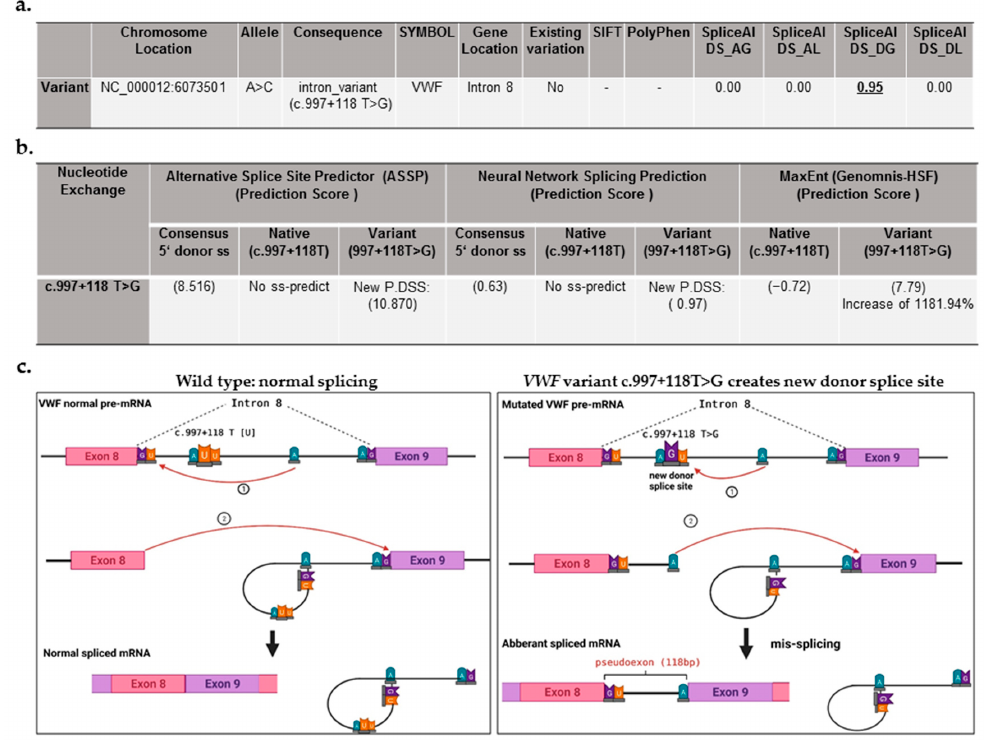
Figure 1. Detection of a deep intronic variant in von Willebrand factor (VWF) gene after executing next-generation sequencing (NGS) and subsequent bioinformatic analysis. ( a ) Data obtained from analysis of variant c.997 + 118 T > G, detected by NGS, using Ensemble Variant Effect Predictor (VEP), including variant annotation, variant location, the existing variant in public variant data- bases, and predicting its pathogenic effect. Genomic location of VWF variant is annotated based on latest assembly (GRCh38/hg38: chr12: 5,948,877–6,124,770). No: not existing in the public variant databases. SpliceAl (Illumina artificial intelligence splicing prediction software) prediction scores include DS_AG (delta score for acceptor gain), DS_AL (delta score for acceptor loss), DS_DG (delta score for donor gain), and DS_DL (delta score for donor loss). The calculated scores range from 0 to 1 and can be interpreted as the probability of the variant being splice-altering. The suggested cutoffs are 0.2 (high recall), 0.5 (recommended), and 0.8 (high precision). The VEP-SpliceAl tool predicted the variant c.997 + 118 T > G induces the gain of a donor splice site, providing the DS_DG score of 0.95. -, not applicable, the SIFT and Polyphen predict the effect of exonic variants on protein func- tion/structure. ( b ) Summary of bioinformatic analysis (by Neural Network Splicing, Alternative Splice Site Predictor, and plug-in MaxEnt of the Human Splicing Finder (HSF)), predicting the im- pact of the VWF gene ( VWF) variant c.997 + 118 T > G on splicing processing. ss, splicing site; P.DSS, potential donor splice site. ( c ) Schematic image of normal splicing of the wild-type VWF mRNA at exon/intron 8 junction (left side) as well as the mis-splicing due to the variant c.997 + 118 T > G, embedded in intron 8 of VWF , which creates a new donor splice site, leading to an aberrant mRNA with exon elongation (a pseudoexon of 118 base pairs (bp)). 2.2. ECFC Characterization: Confirming Endothelial Cells’ Phenotype